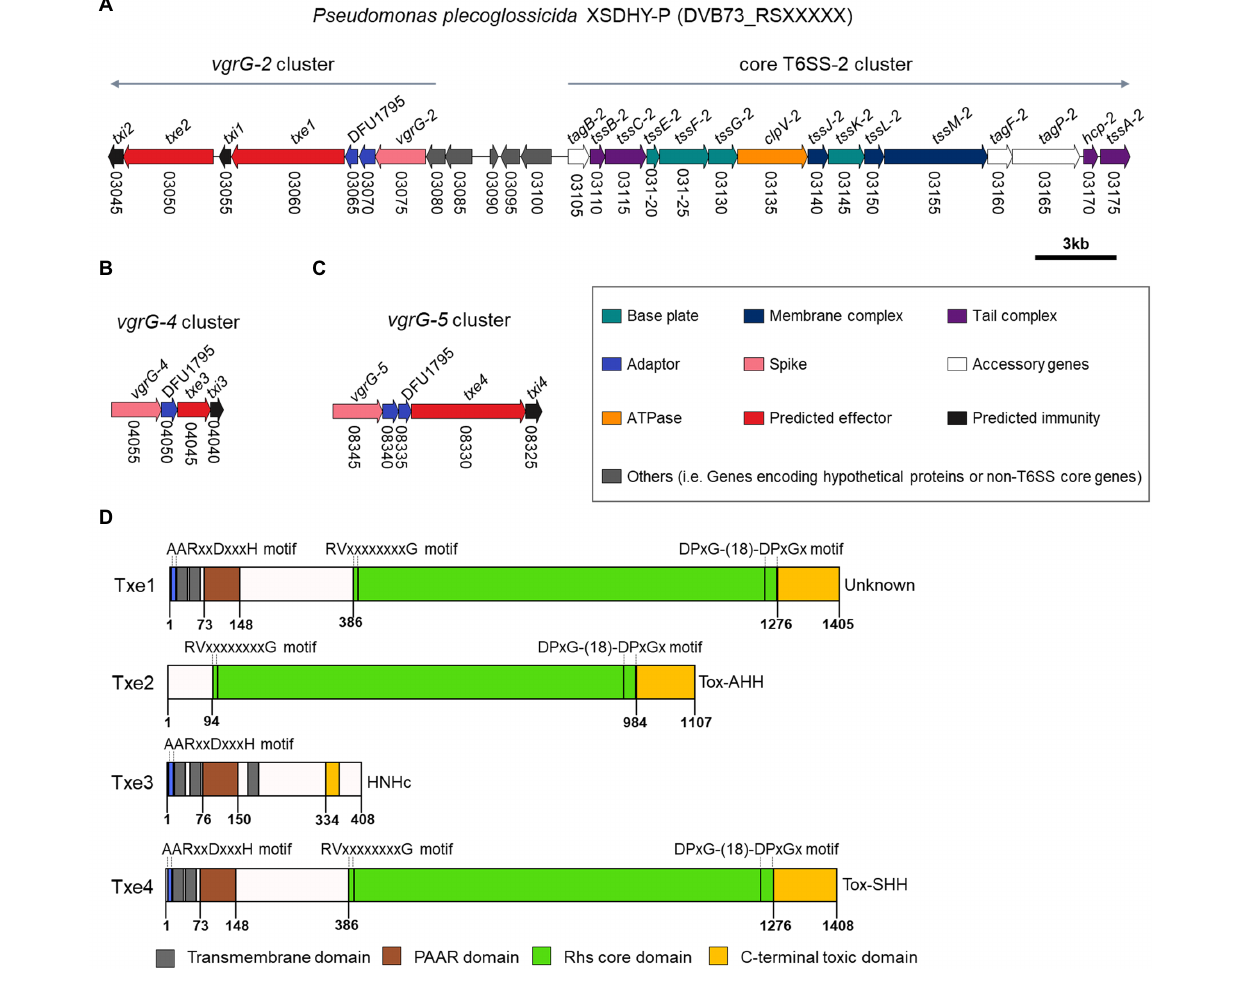
Signal peptide analysis using the SignalP 5.0 program revealed no signal peptides present in any of immunity proteins ( Supplementary Table S3 ). Moreover,